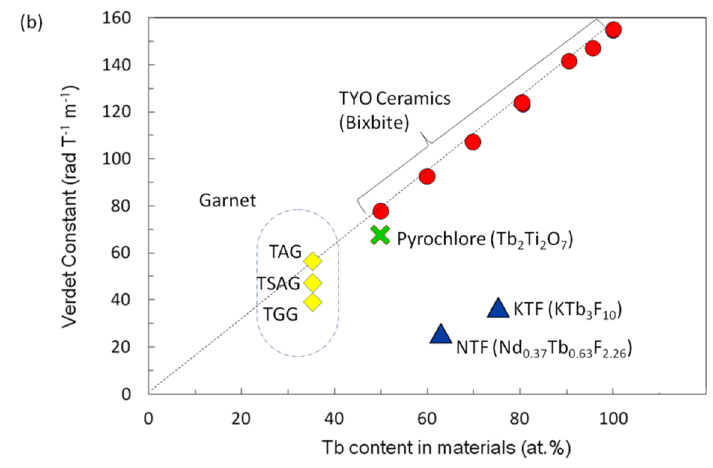
Figure 5. ( a ) Wavelength dependency of the Verdet constant for the TGG single crystal and the (Tb 0.6 Y 0.4 ) 2 O 3 and Tb 2 O 3 ceramics. ( b ) Relationship between the concentration of Tb ions in (Tb x Y 1−x ) 2 O 3 ceramics and Verdet constant for 1 µm wavelength.